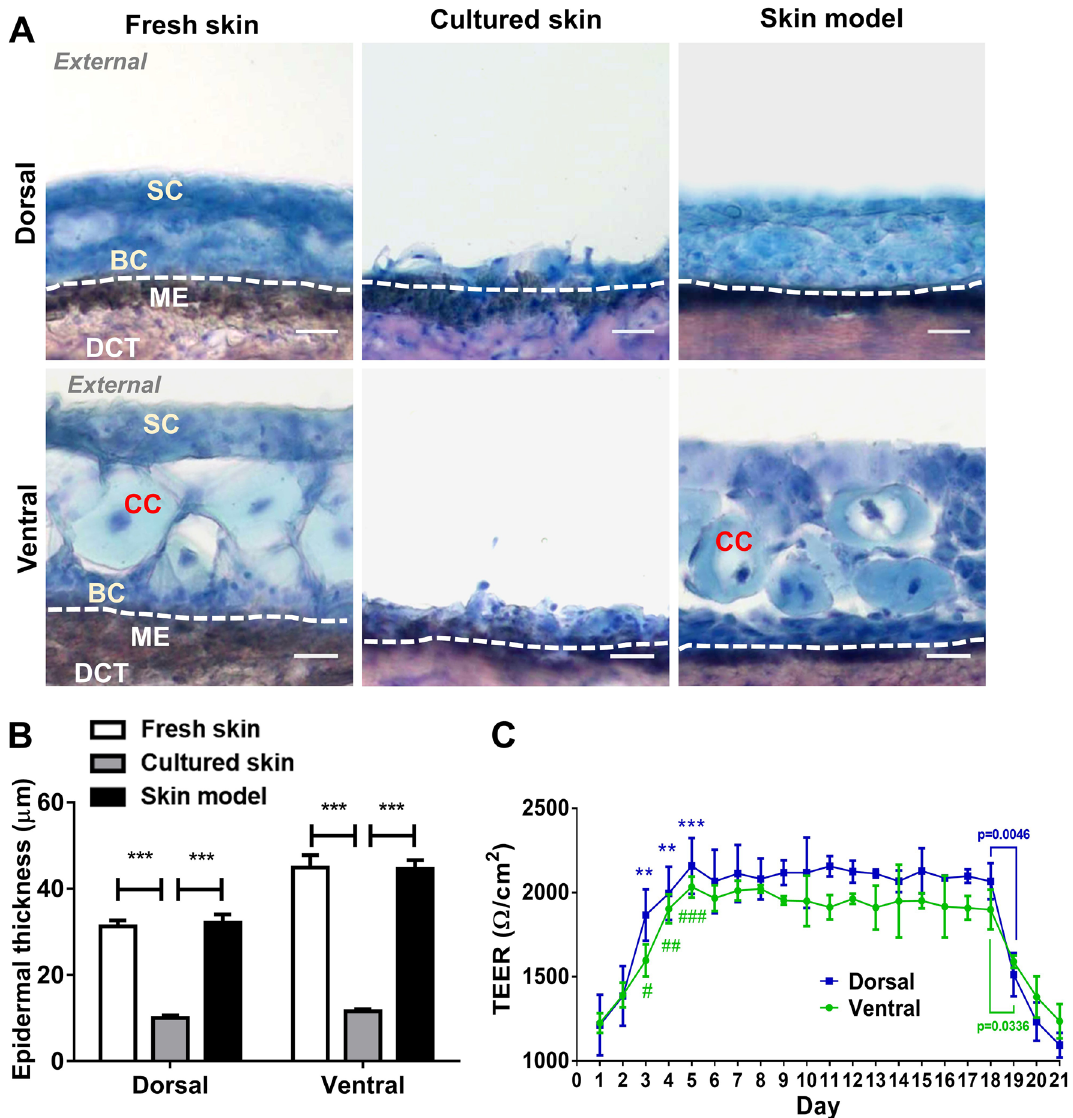
Figure 2. Morphological and functional examination of the skin model. Fresh skin and 5-day cultured skin and skin model were cryo-preserved and sectioned. ( A ) Tissue sections of dorsal and ventral regions were stained with Giemsa stain. Sections showing the superficial epithelial cells (SC), basal epithelial cells (BC), melanophores (ME), dense collagenous tissue (DCT), club cells (CC). Shown are representative images, Bar = 10 μm. ( B ) Images used to determine epidermal thickness. All data are shown as mean values (± SEM). Four fish with three replicates of tissue from each were used. The morphometric evaluation was determined from 20 randomly selected fields per sample in each condition. Statistical significance was determined using one-way ANOVA followed by Bonferroni post hoc test for comparison of epidermal thickness between three conditions under the same subject numbers. ( C ) The transepithelial electrical resistance (TEER) was measured in the skin model for a consecutive 21 days. All data were shown as mean values (± SEM). Four fish and three replicates of tissue from each were used. Statistical significance was determined by using Student’s t-test. ***p ≤ 0.001; **p ≤ 0.01; *p ≤ 0.05 versus Dorsal group Day1; ### p ≤ 0.001; ## p ≤ 0.01; # p ≤ 0.05 versus Ventral group